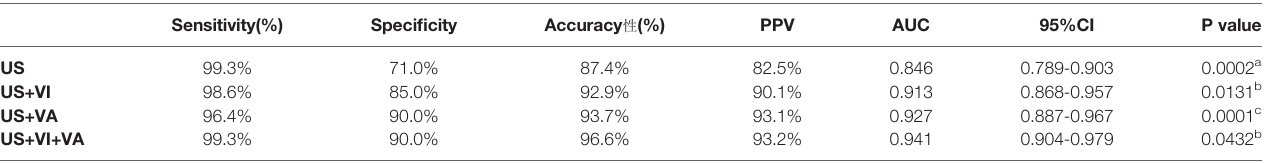
TABLE 5 | Diagnostic ef fi cacy of SMI combined with conventional